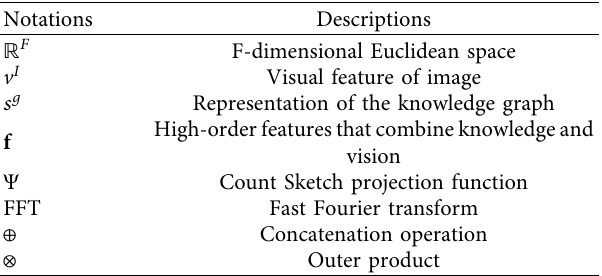
Figure 2: Overview of our KGFR framework. It consists of a visual feature extraction module, a knowledge expression module, and a knowledge fusion module. In visual feature extraction module, the CNN can extract the overall visual features in images. In the knowledge representation module, the constructed knowledge graph is split into two subgraphs, and the representations of the nodes are obtained by two GATs, respectively. Finally the knowledge representations of the same nodes in different GATs are concatenated to obtain the final knowledge representation. In the knowledge fusion module, the MCB module is introduced to fuse the knowledge representations with the extracted visual features, so as to enhance the fine-grained image classification. Table 1: Notations used in this